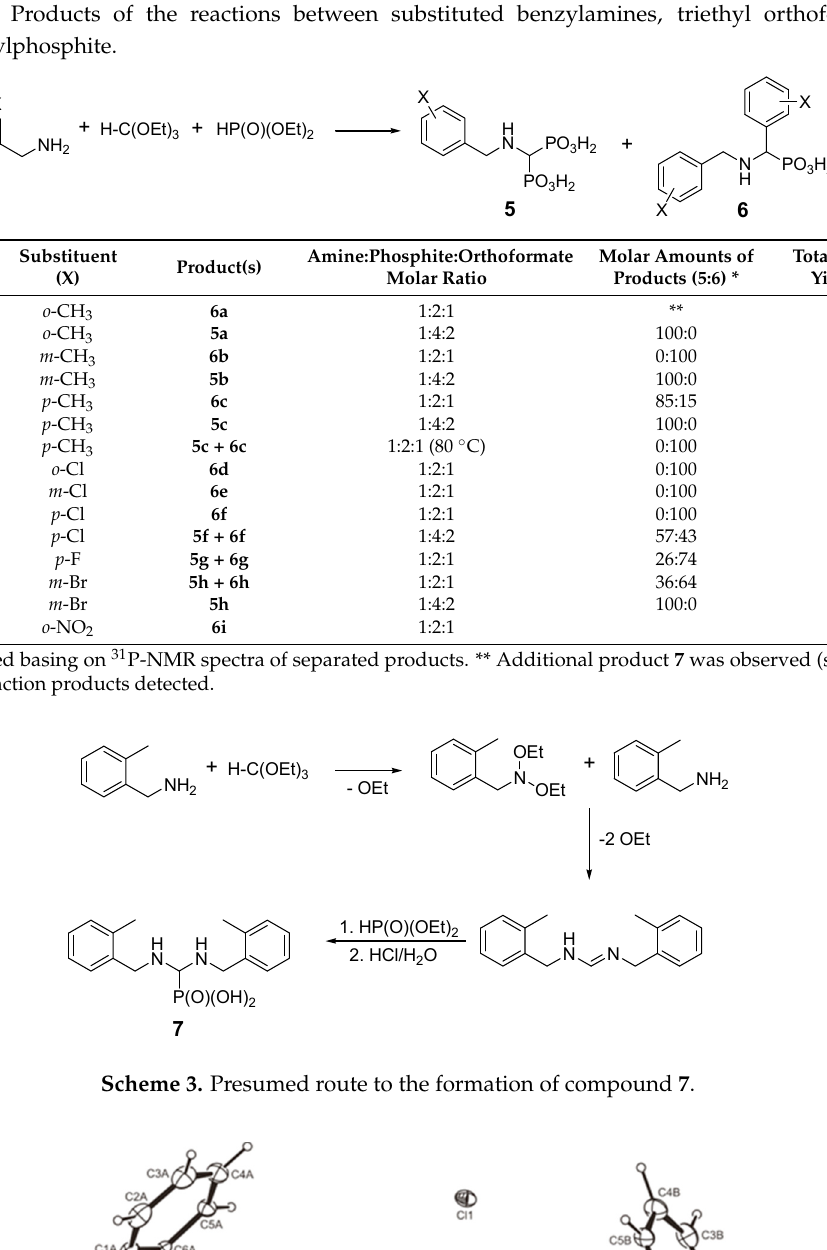
Figure 1. The crystal structure of molecule 6d . Displacement ellipsoids are drawn at a 20% probability level.